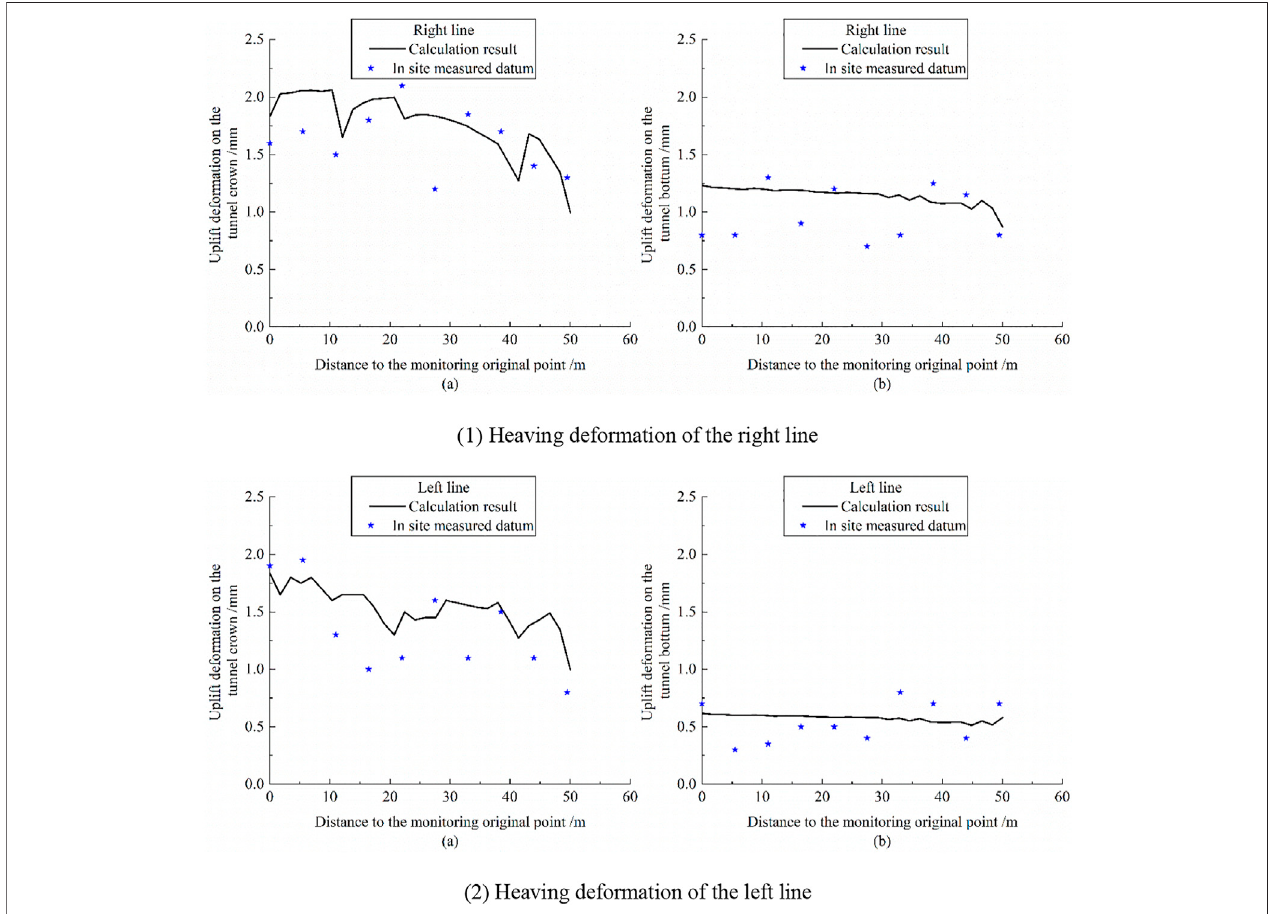
FIGURE 14 | Heaving deformation contrast on the tunnel between the calculation result and the in site measured datum.